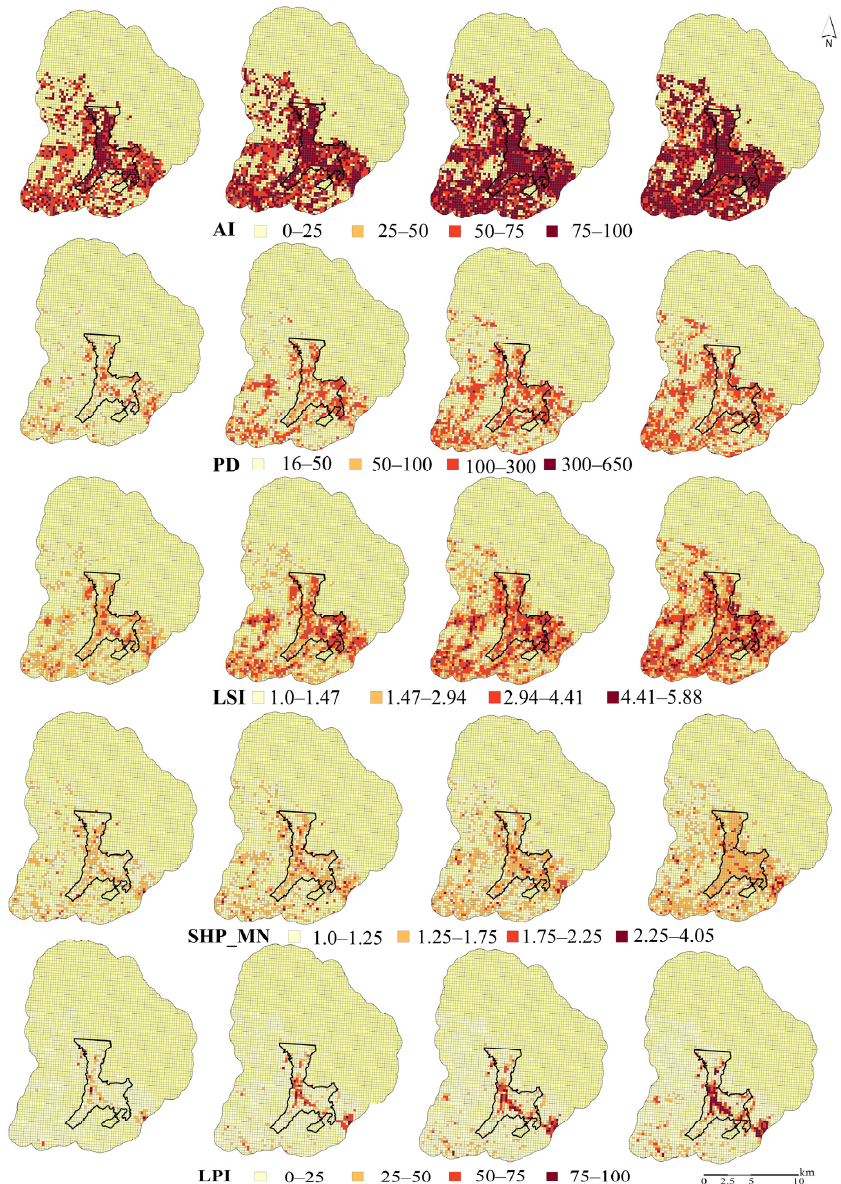
Figure 6. Spatiotemporal evolution of selected landscape metrics at 250 m cell size in 2002, 2010, 2016, and 2019 in Dharamsala.